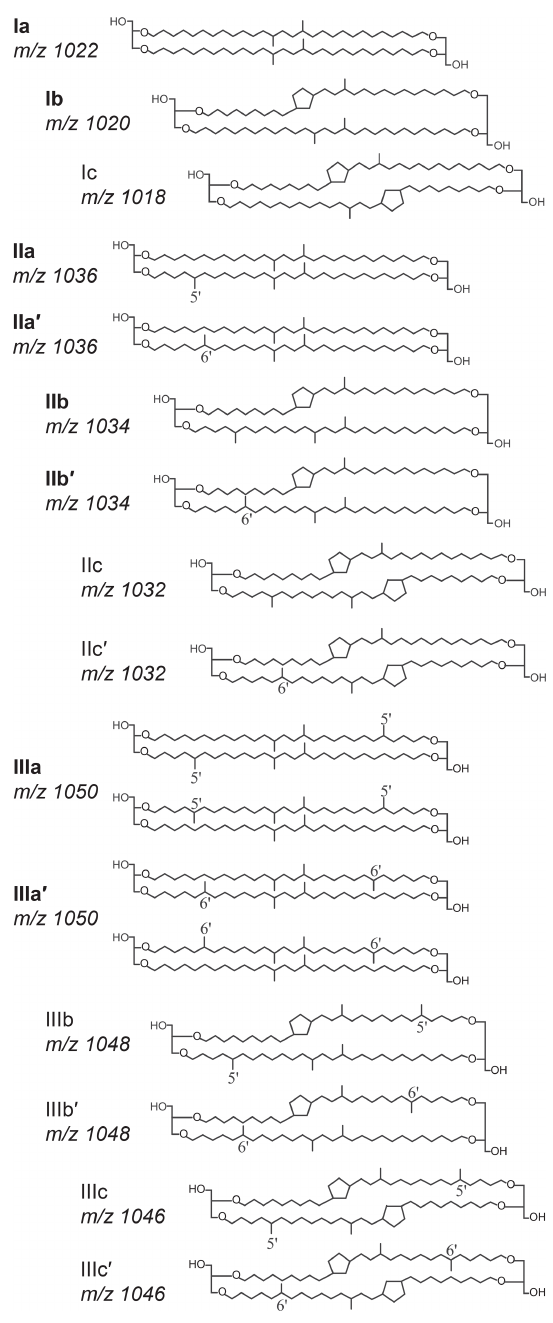
Figure 1. Molecular structures of brGDGTs, consisting of two ether-linked dialkyl chains with zero to two additional methyl branches (I, II and III) and zero to two cyclopentyl moieties (suf- fixes a, b and c). The 6-methyl isomers are denoted with a prime. Compounds indicated in bold are the eight most common brGDGTs encountered in Lake Chala and focused upon in data presentation and